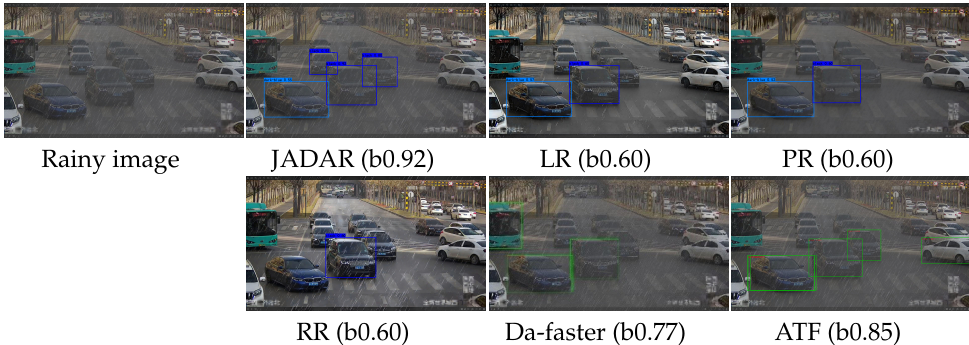
Figure 9. Example 1 of test results of JADAR and two-stage methods on the Rain Vehicle Color-24 test